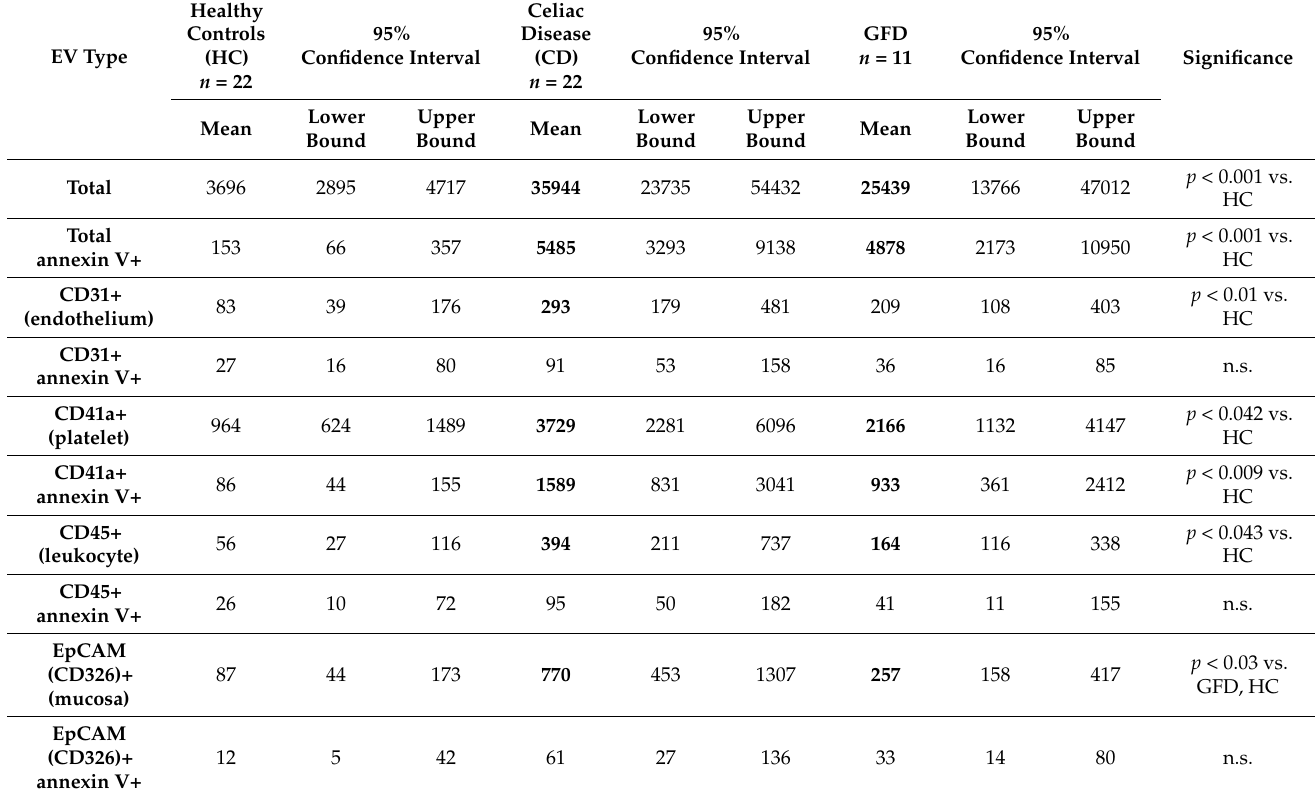
Table 3. Differences in total and specific EV counts between groups 3 .